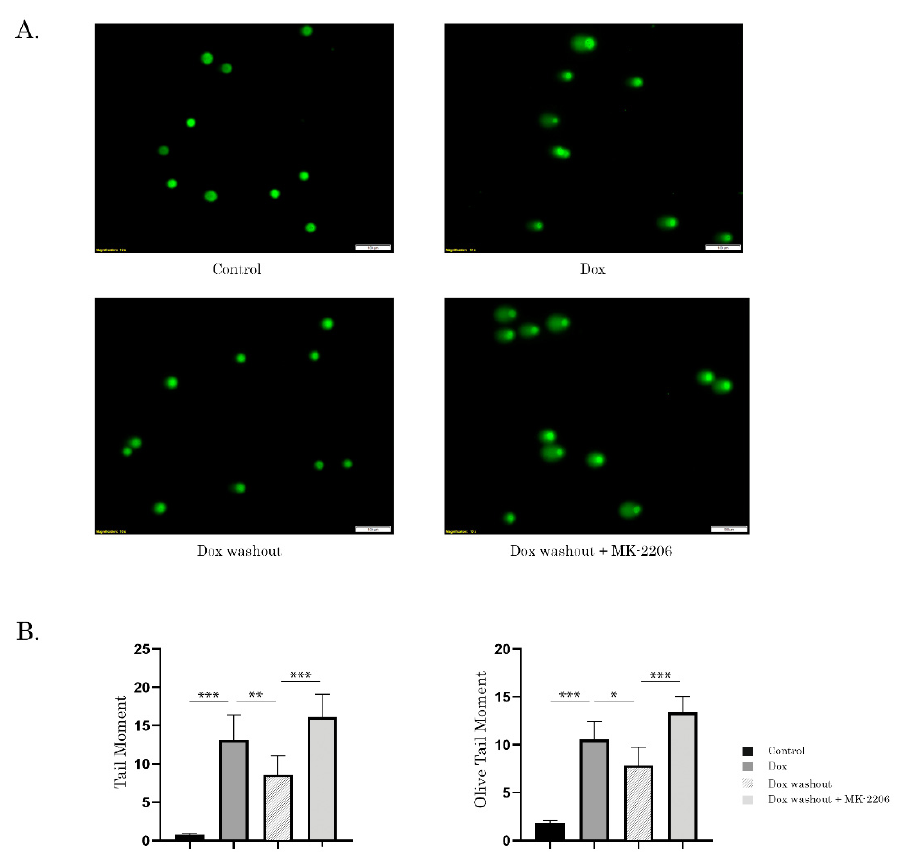
Figure 3. Inhibition of AKT-signaling attenuates DNA double-stand break (DSB) repair. GIST T-1R cells treated with DMSO (negative control) and Dox 0.5 µ g / mL for 2 h. After the drugs were washed out, cancer cells were further cultured in absence (Dox washout) or presence of MK-2206 (5 µ M), an AKT inhibitor (Dox washout + MK-2206) for 8 h. ( A ) representative images of comets from the experimental settings shown above (Scale bars = 100 µ m). ( B ) graphic depiction of the calculated tail moment (TM) and olive tail moment (OTM) from alkaline comet assay shown in Figure 3A. Columns, mean of at least three independent experiments with a minimum of 50 cells counted per each experiment; bars, SE. * p < 0.05; ** p < 0.01; *** p < 0.001.